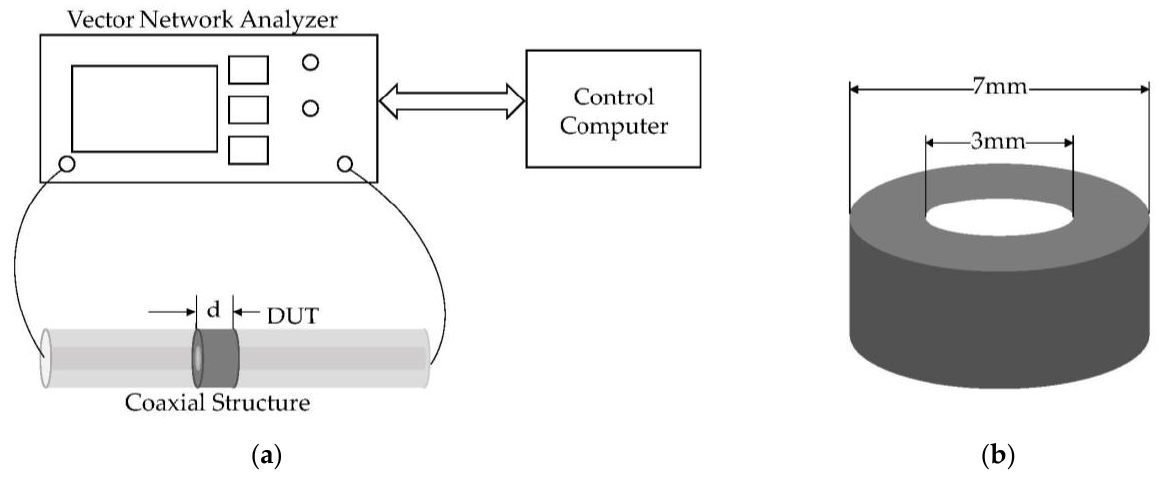
Figure 1. Denim performance test equipment and DUT ( a ) equipment for coaxial ring method test ( b ) DUT.